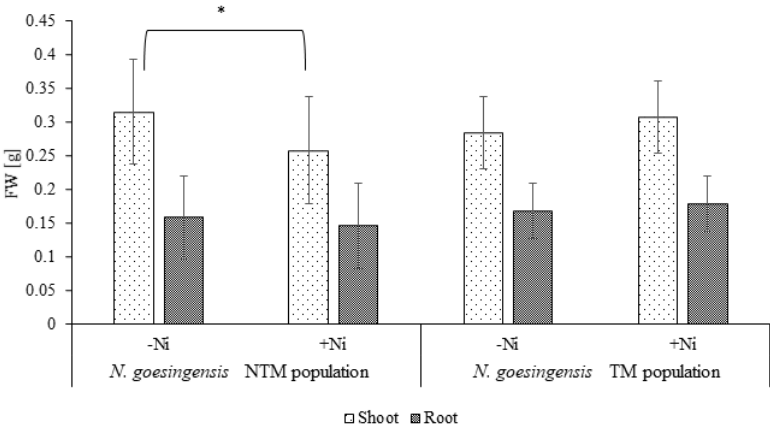
Figure 1. Fresh biomass of roots, shoots and whole plants of both N. goesingensis ecotypes in control and Ni treatment conditions. The asterisk indicates the statistical significance of the t-test at p ≤ 0.05, error bars represent ± SD (N = 15).